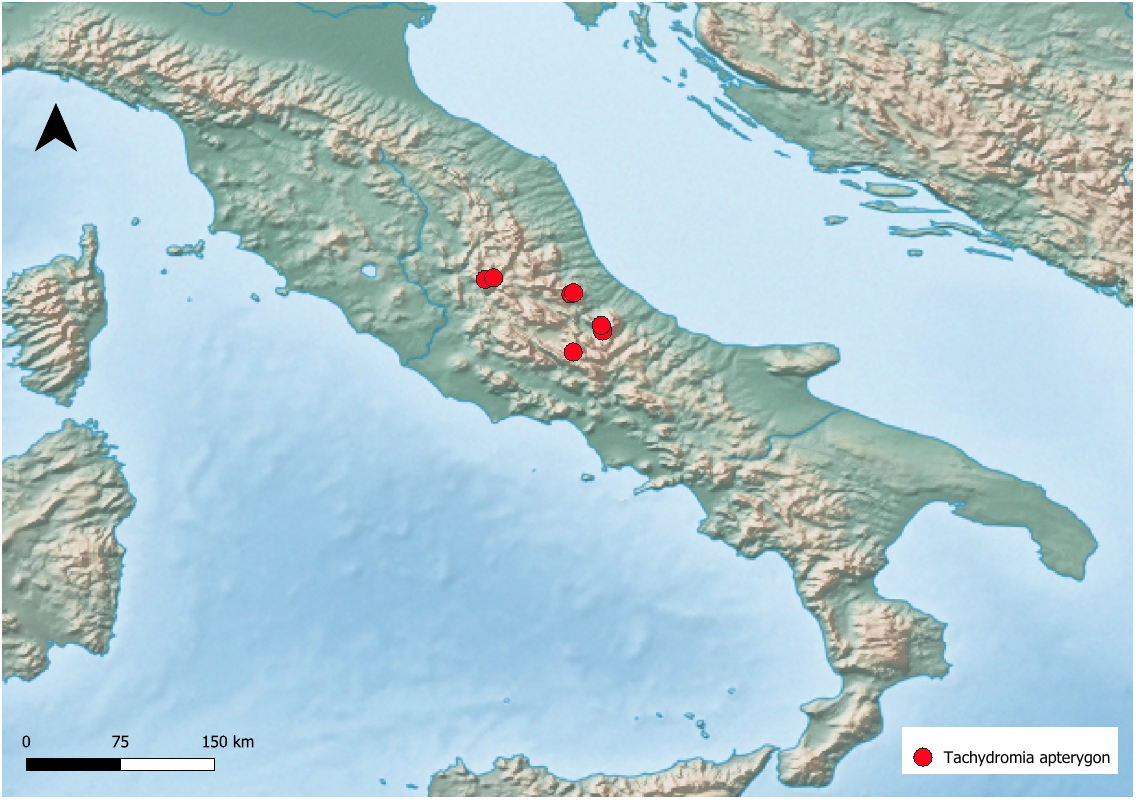
Fig. 23. Distribution of Tachydromia apterygon Plant & Deeming, 2006 in Italy. Nine localities are currently